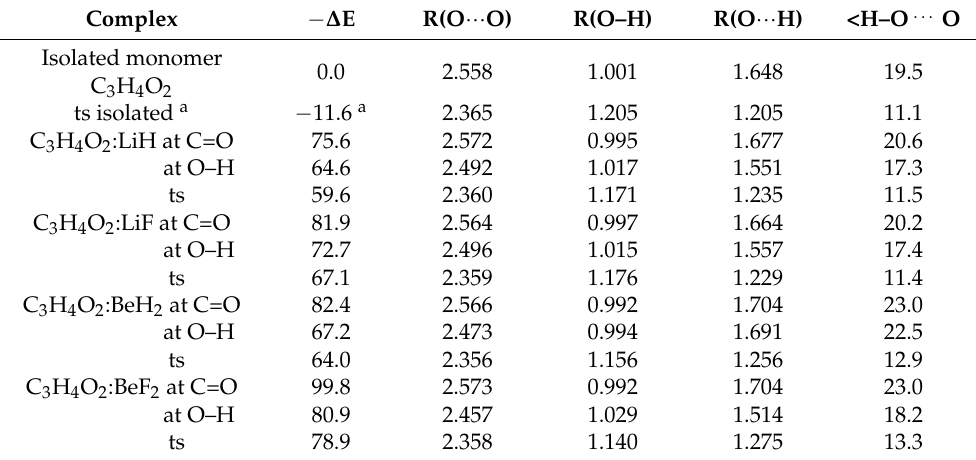
Table 1. Binding energies ( − ∆ E, kJ · mol − 1 ), distances R (Å), and H–O–O angles (<, o ) for complexes of C 3 H 4 O 2 with